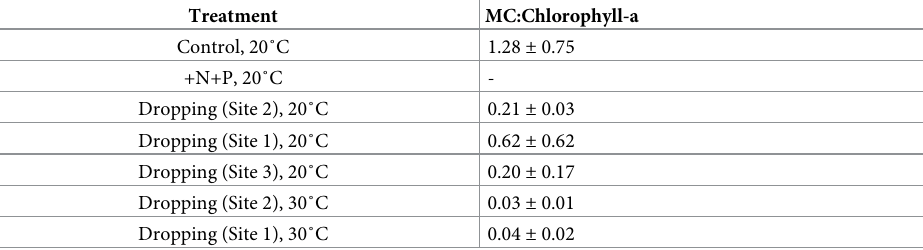
Table 1. Total microcystin (MC) to cyanobacterial chlorophyll-a ratios (mean ± 1 SD in μ g μ g -1